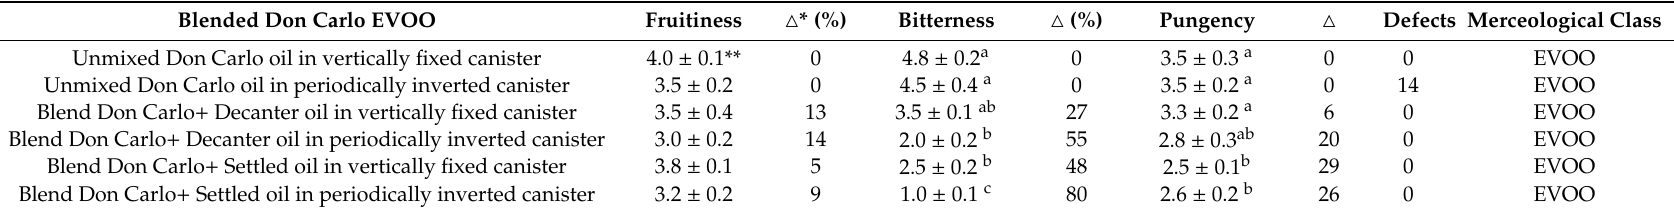
Table 5. Sensory profile of unmixed and blended Don Carlo EVOO after three months of storage.